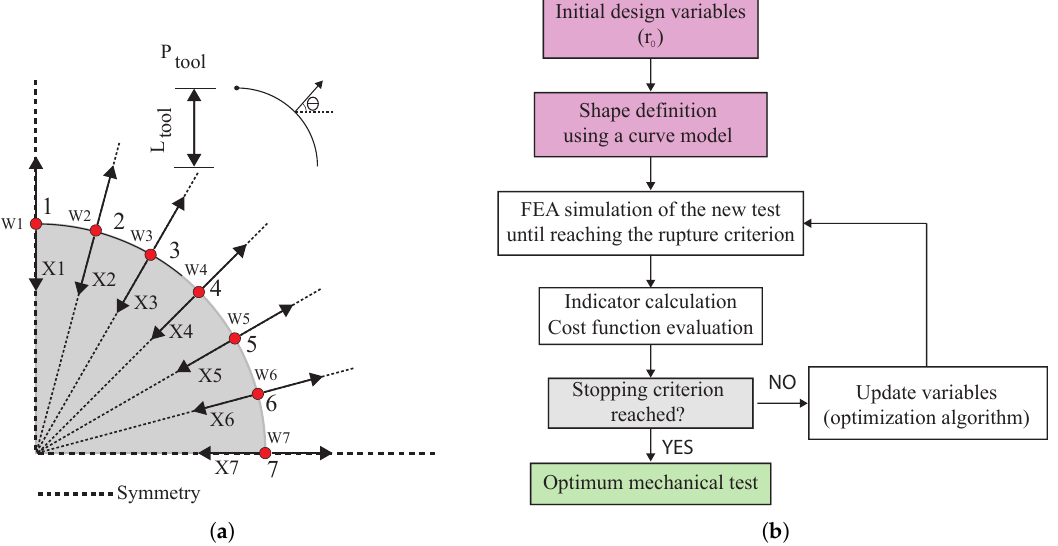
Figure 1. ( a ) Definition of the design variables (here, for n = 7 and θ = 90 ◦ , data from [4]) and ( b ) the general optimization